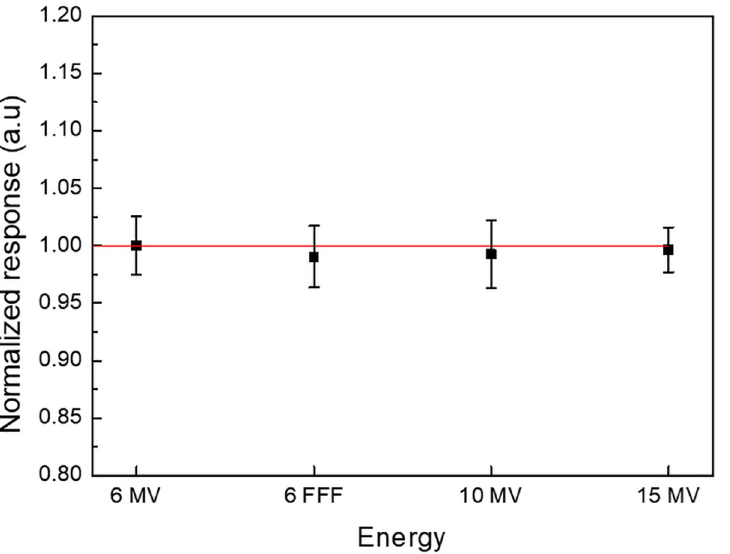
Fig 6. Energy dependence of